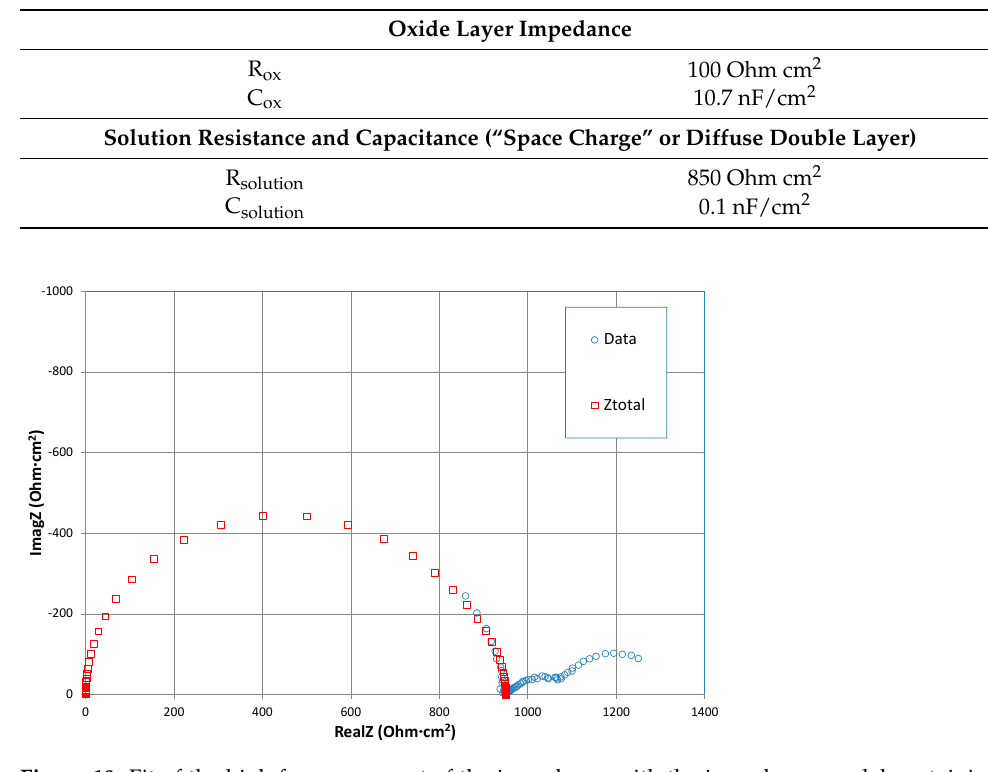
Figure 10. Fit of the high frequency part of the impedance with the impedance model containing only the oxide layer and solution impedance (ohmic resistance and space charge).